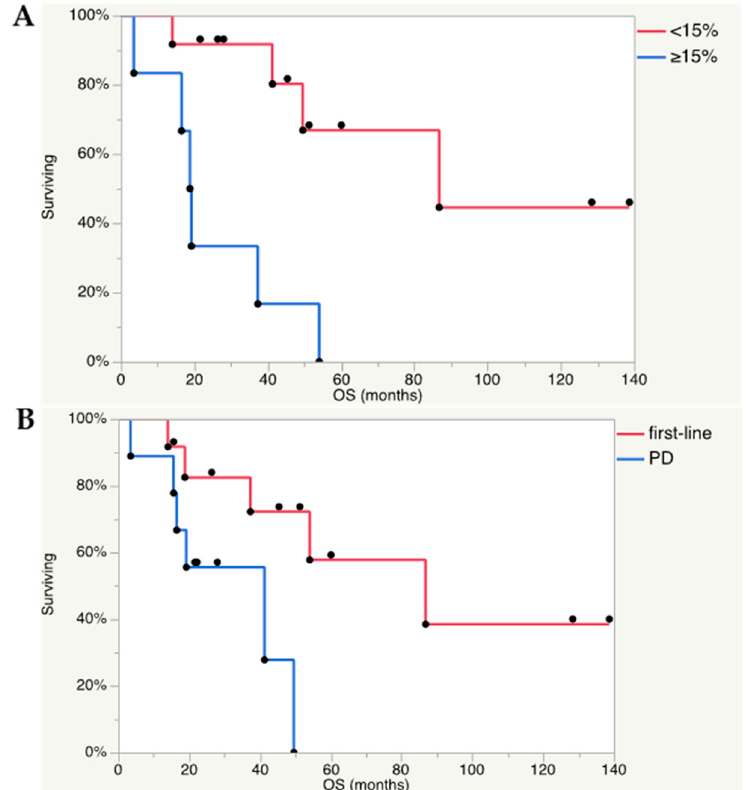
Figure 2. ( A ) Ki-67 index <15% in the Kaplan–Meier analysis was found as a positive predictive